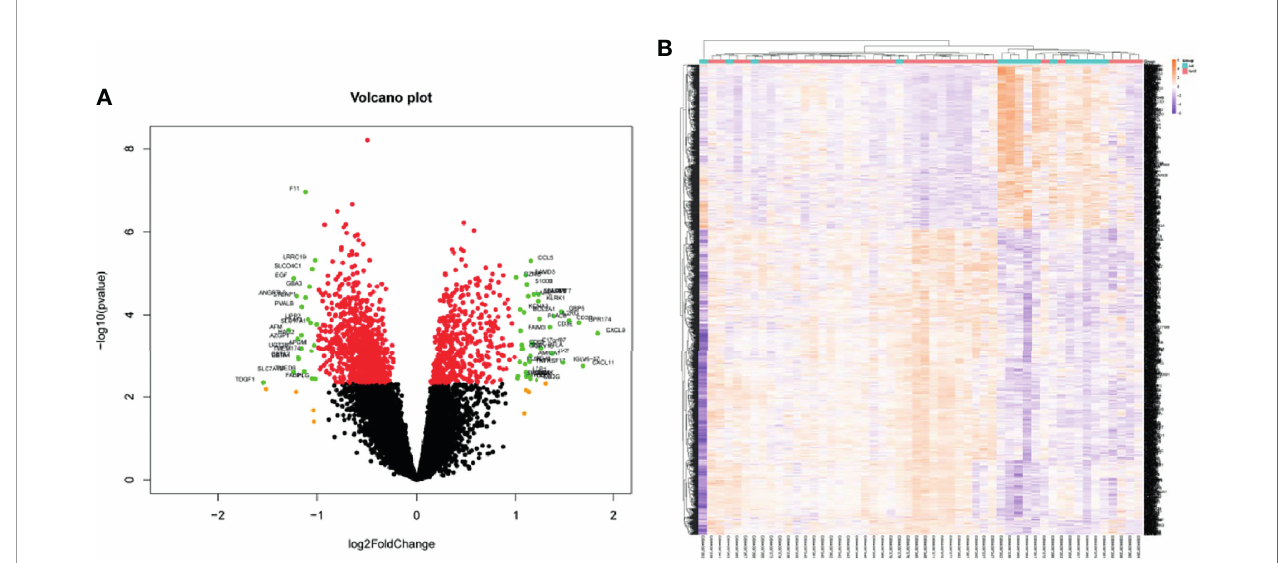
FIGURE 1 | Screening for differentially expressed genes in the percutaneous allograft biopsy of 15 AR patients than NAR from GSE138043. (A) Differential genes in volcano plot. Red plots of adjusted p <0.01, orange plots of log2FC>1, green plots of both. (B) The clustering of differential genes in heatmap. The color in the heatmap represents the log2 expression values. Text on the right of heatmap indicates the enriched gene ontology terms for each cluster of genes. AR, rejection at 12 months post-renal transplant; NAR, non-rejection at 12 months post-renal